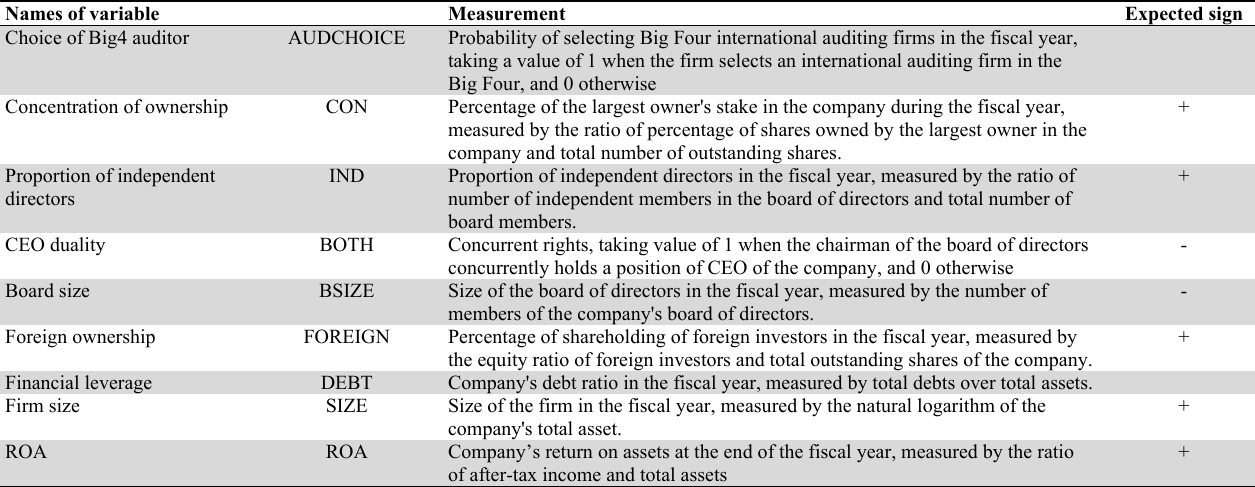
Definitions of variables applied in the research